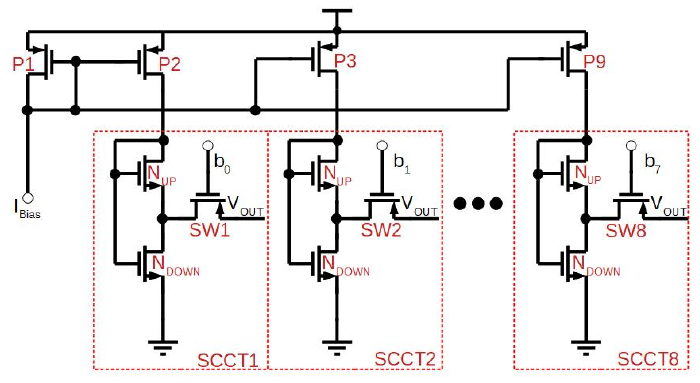
Figure 3. The matrix of SCCTs.